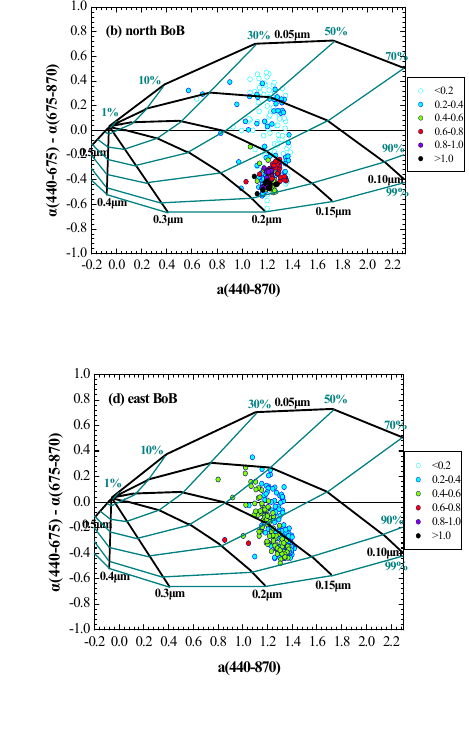
applied over the four BoB sub-regions (Fig. 10). Large dif- ferences in the α vs. dα plots are revealed establishing large heterogeneities in aerosol load, optical properties and modifi- cation processes over BoB. The aerosols over west BoB show high AOD 500 ( > 0.5), clustering in the fine-mode